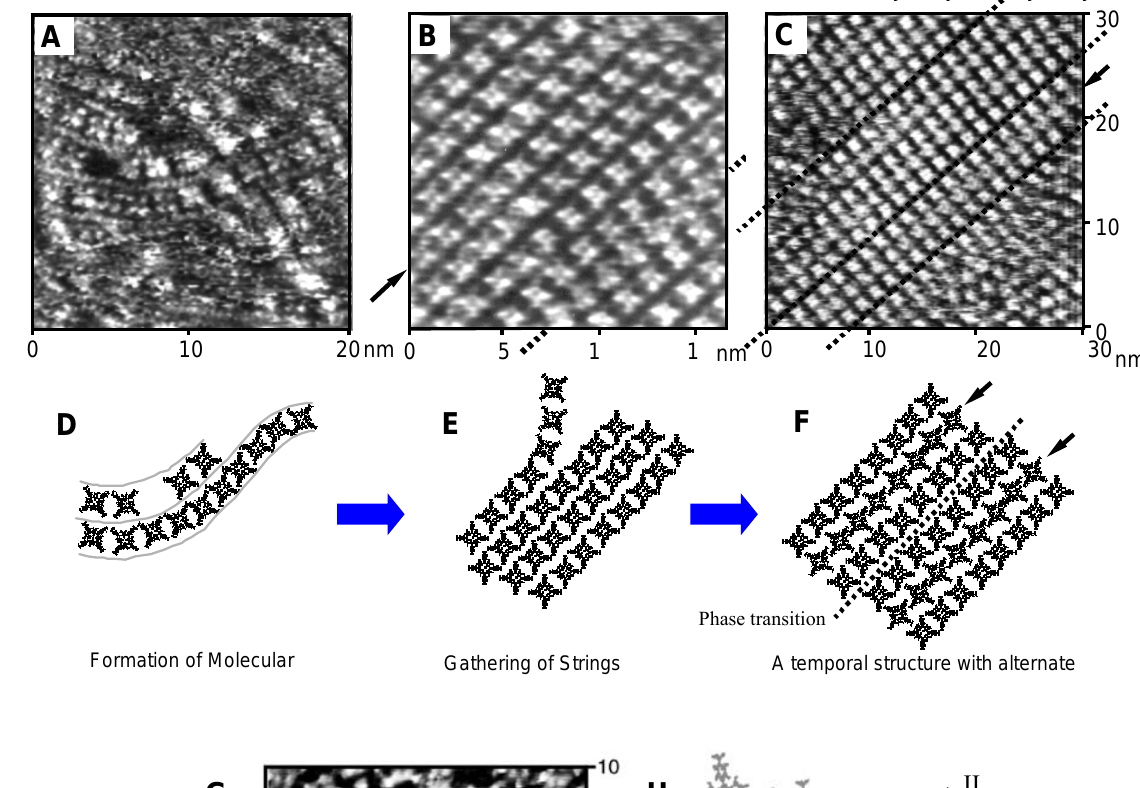
Figure 4. In situ STM images and corresponding models of the self-ordering process of TMPyP on I/Au(111) captured at each step of adsorption and ordering. Adapted with permission from reference [12]. Copyright 1995 American Chemical Society.